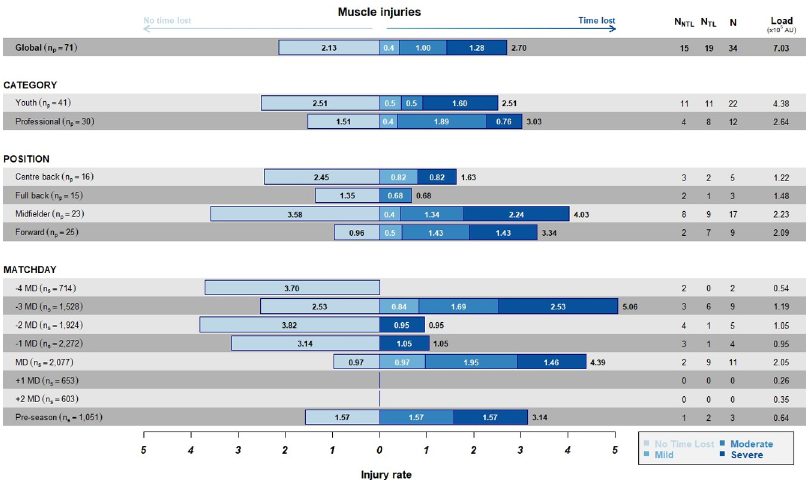
Fig 6. Incidence of TL and NTL injuries per 10 5 au of PL stratified by category, position, and days to/from the match. Numbers inside bars represents the incidence according to the severity.